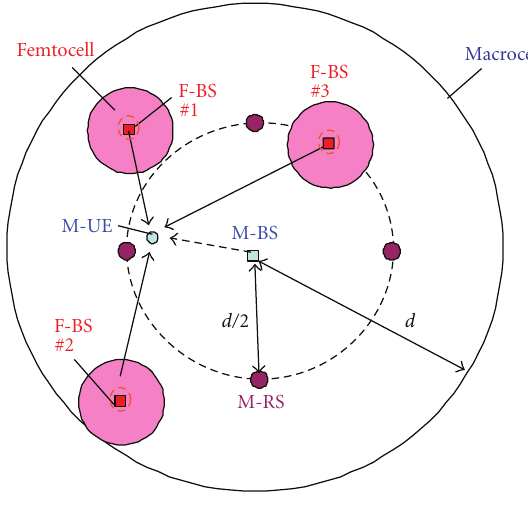
Figure 12: Location of M-BS, M-UE, F-BS, and M-RS.